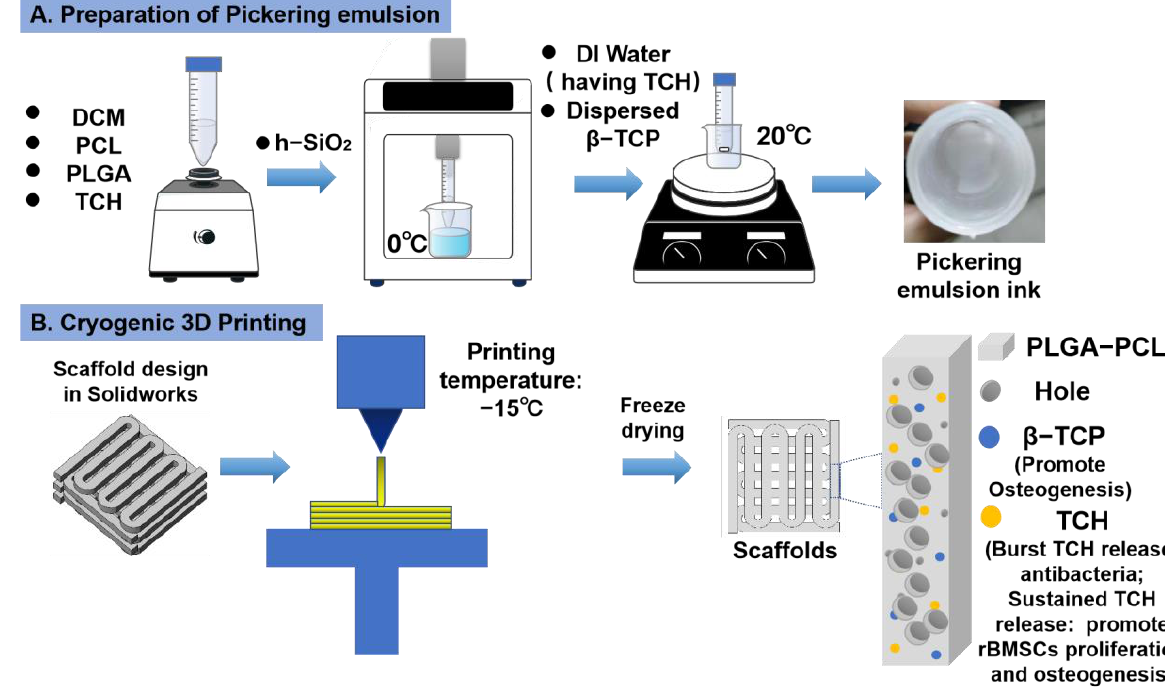
Figure 1. Schematic illustration of Pickering emulsion ink formulation and 3D printing of drug- loaded scaffolds. ( A ) The formulation of Pickering emulsion inks. ( B ) Cryogenic 3D printing of hierarchically porous bone tissue engineering scaffolds loaded with